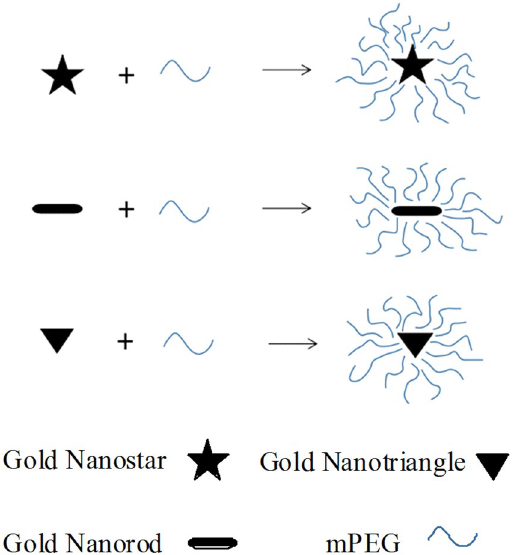
Figure 1. Schematics of gold nanostar, gold nanorod and gold nanotriangle loading into